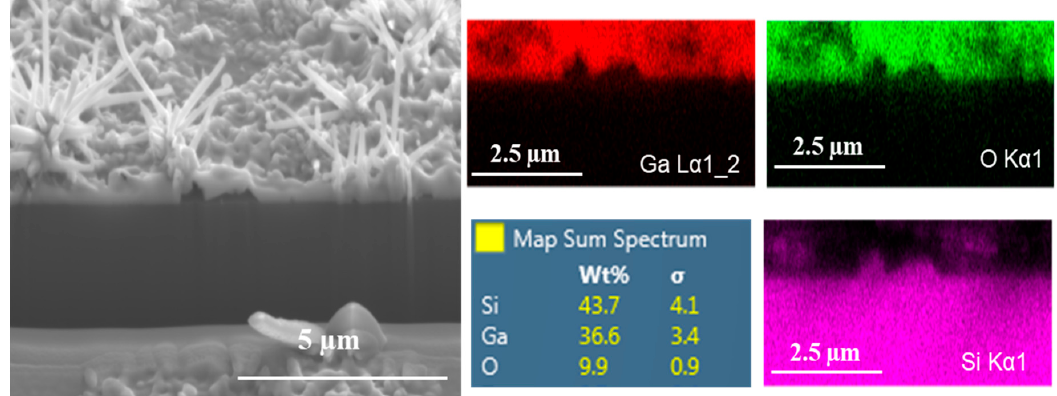
Figure 7. A cross-section of SEM and EDS mapping of grown Ga 2 O 3 nanostructures on N-Si with the presence of a liquid silver catalyst at 1000 ◦ C and associated elemental maps for Ga, O, and Si. Star-like shape of Ga 2 O 3 nanowires were observed, with nanowire lengths in the range of 5–10µm.